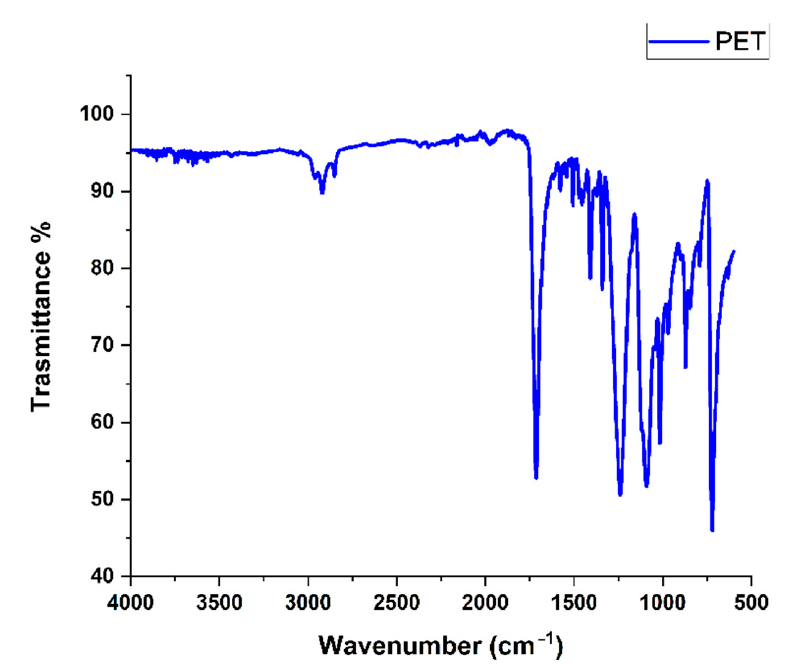
Figure 2. IR spectra of the floating fraction of the feedstock: LDPE (violet line) and polyethylene contaminated with aromatic polyester (light blue line).